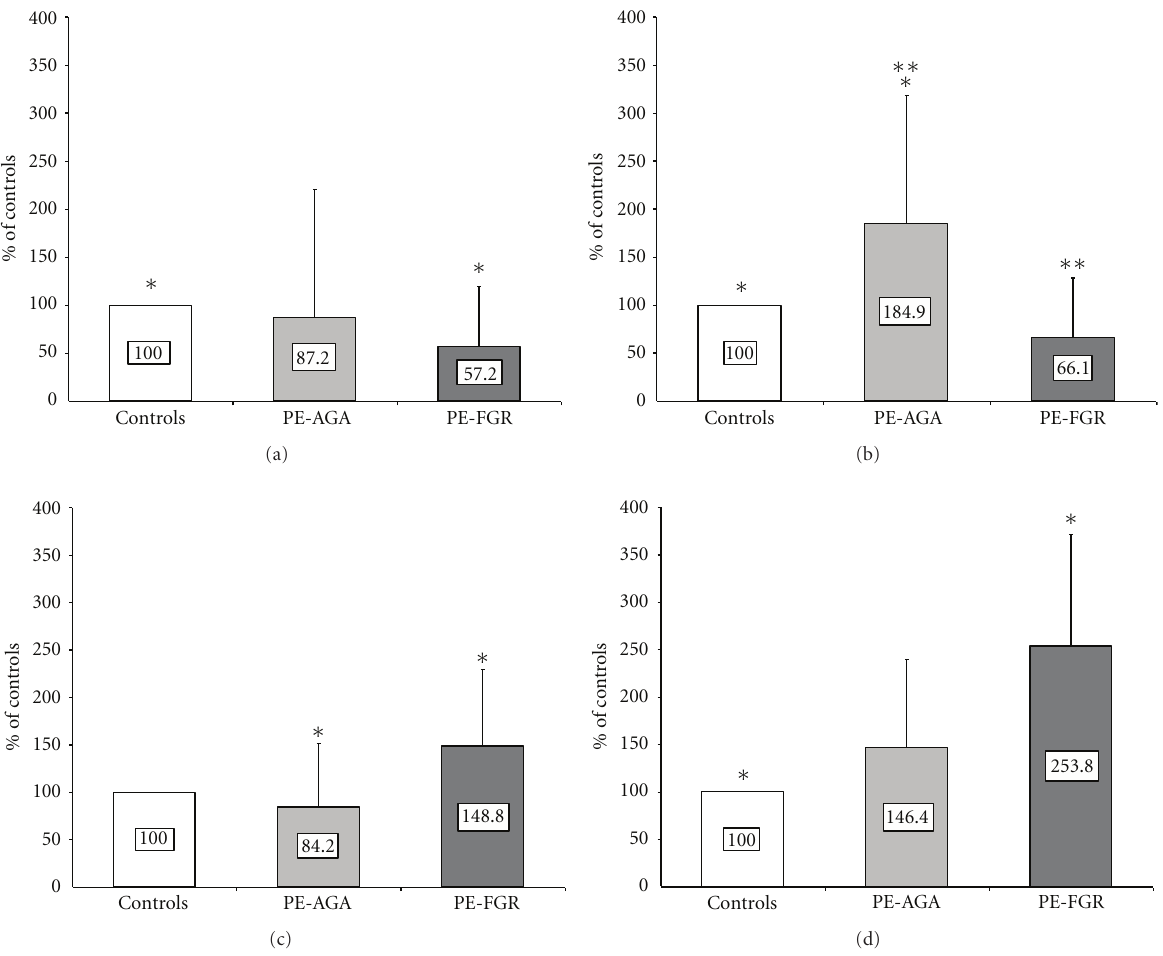
Figure 1: MIF ELISA assay in normal and pathological samples. (a) placenta, ∗ P < 0 . 001 (control tissues versus PE-FGR); (b) fetal membranes, ∗ P = 0 . 03 (control tissues versus PE-AGA) and ∗∗ P = 0 . 004 (PE-AGA versus PE-FGR); (c) umbilical cord, ∗ P = 0 . 047 (PE-AGA versus PE-FGR); (d) maternal serum, ∗ P = 0 . 023 (CTRL versus PE-FGR). P values were calculated by ANOVA test, followed by Tamhane test for pair-wise